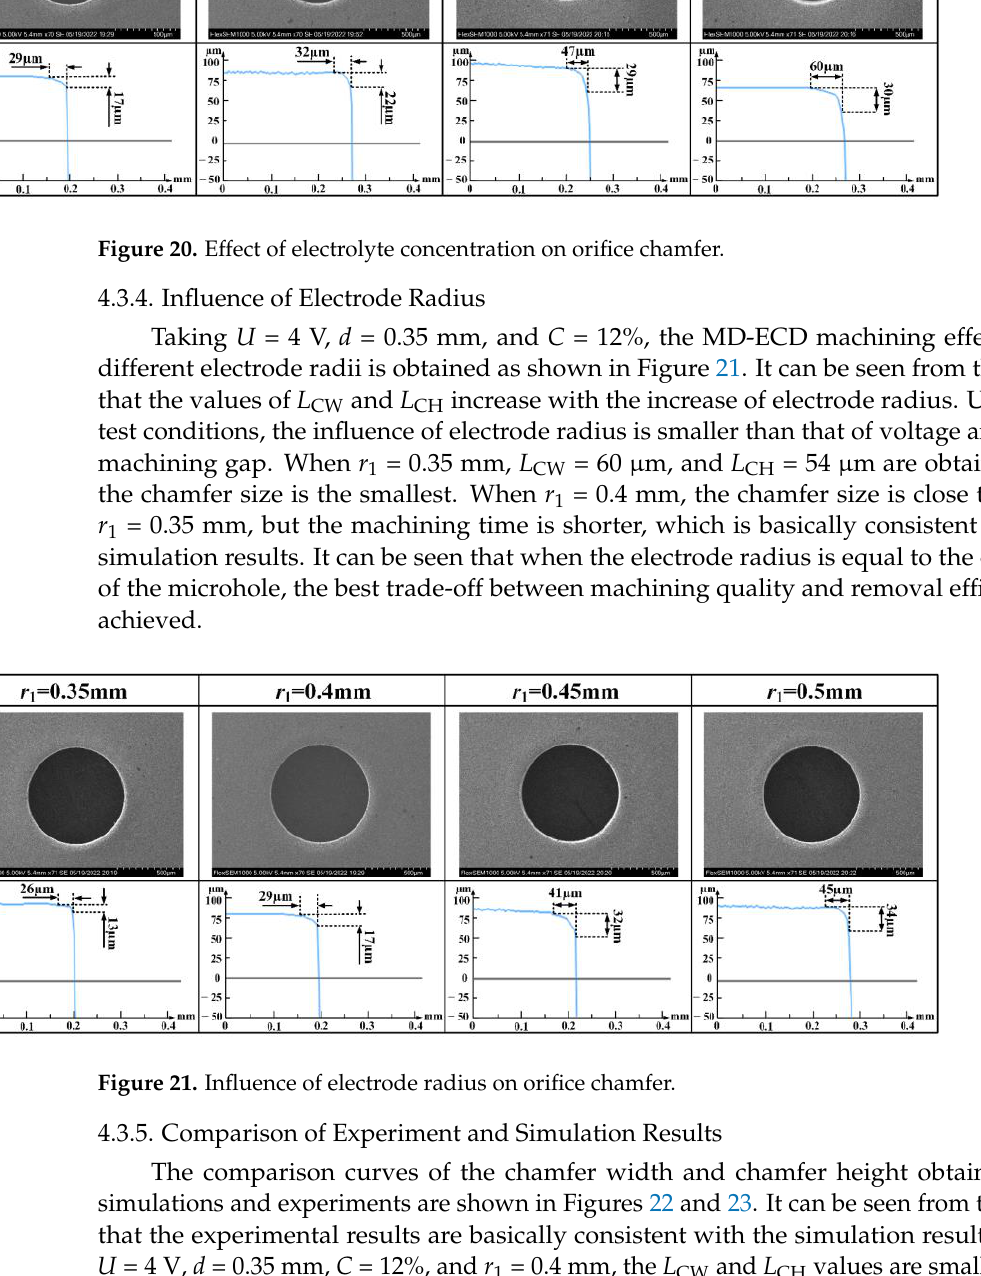
Figure 22. L CW comparison curve: ( a ) Effect of machining voltage; ( b ) Effect of initial machining gap; ( c ) Effect of electrolyte concentration; ( d ) Effect of electrode radius. In general, the chamfer size obtained in the experiment is slightly smaller than the simulation size, mainly because the simulation fails to consider the influence of electro- lytic bubbles. The bubble layer formed by the accumulation of bubbles (as shown in Figure 15) has an insulating effect and weakens the electrolysis effect. In addition, when U = 7 V, the chamfer size error is larger, which is mainly because when the voltage increases, the number of bubbles generated by electrolysis increases, and the influence of the bubble layer is more obvious, so when U = 7 V, the chamfer width and chamfer height obtained from the test deviate greatly from the simulation value.